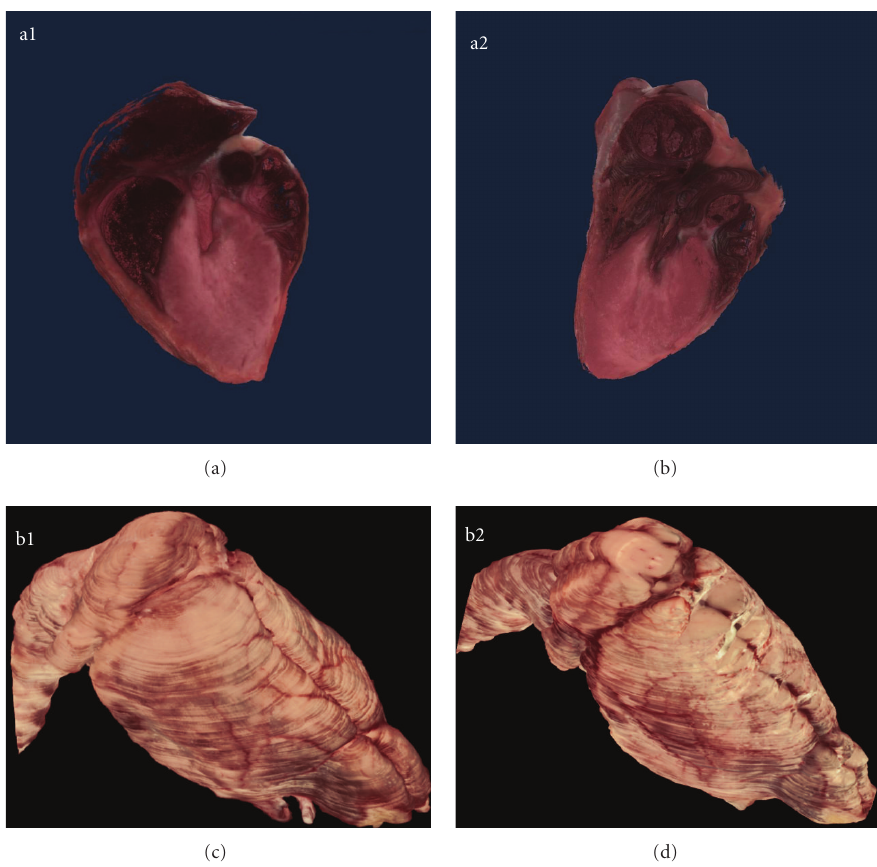
Figure 4: Organ visualization. Cutaway through the 3D reconstructed hearts of the PEPCK-C mus (a1) and control mouse (a2) reveals the chambers of the heart, pulmonary trunk and pulmonary veins. Manual segmentation of the heart from the 2D images also enabled computation of the heart volume. The heart of the PEPCK-C mus mouse is 351.52 cubicmm in volume, while the heart from the control heart animal is 366.87 cubic mm. Other organs such as the brain of the PEPCK-C mus (b1) and the control mouse (b2) were also semiautomatically segmented, visualized in 3D, and volumes computed. Table 1 lists the comparative volumes. The brain volume was also used as a normalizing factor for comparison of other organ volume